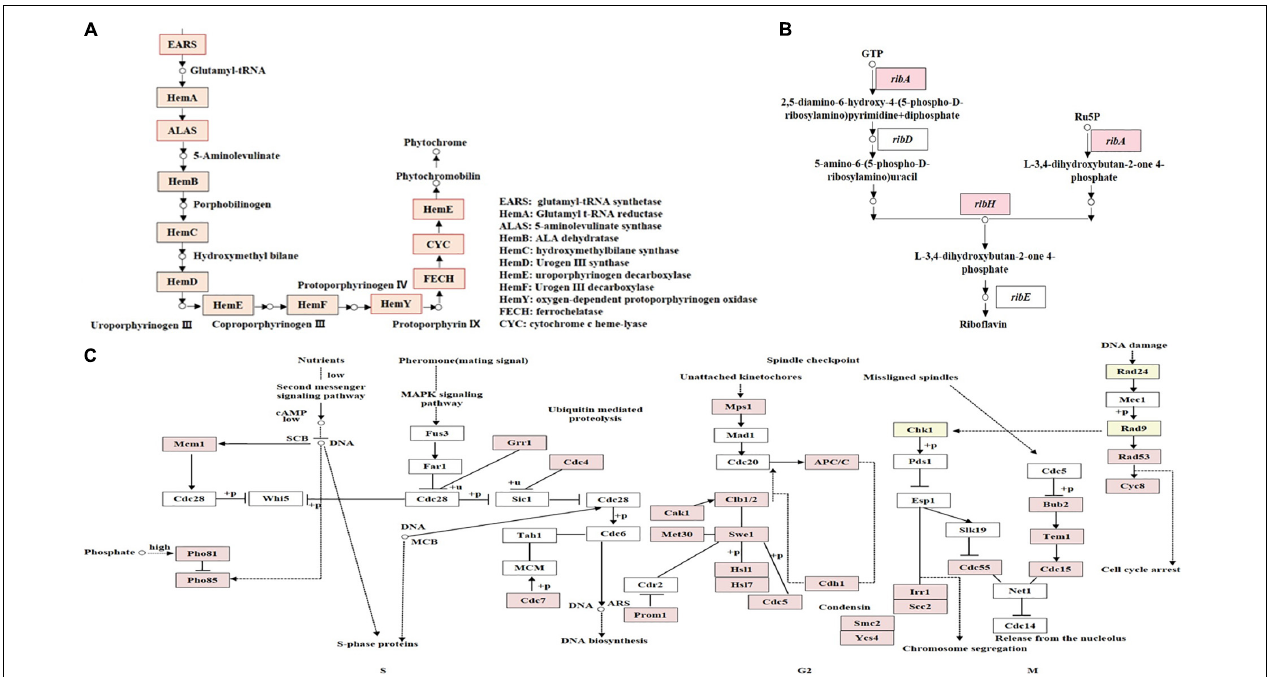
FIGURE 4 | KEGG annotation of DEGs involved in different metabolism pathways. (A) KEGG annotation of proteins encoded by DEGs involved in the phytochrome biosynthesis pathway. The genes whose products are highlighted in red are up-regulated during the FB stages. (B) KEGG annotation of DEGs involved in riboflavin metabolism pathways. Genes highlighted in red are up-regulated during the FB stages. (C) KEGG annotation of DEGs involved in the cell-cycle. DEGs between VM and FB are shown in the cell-cycle pathway at the S, G2, and M phases. Genes whose products are highlighted in red are up-regulated during the FB stages.